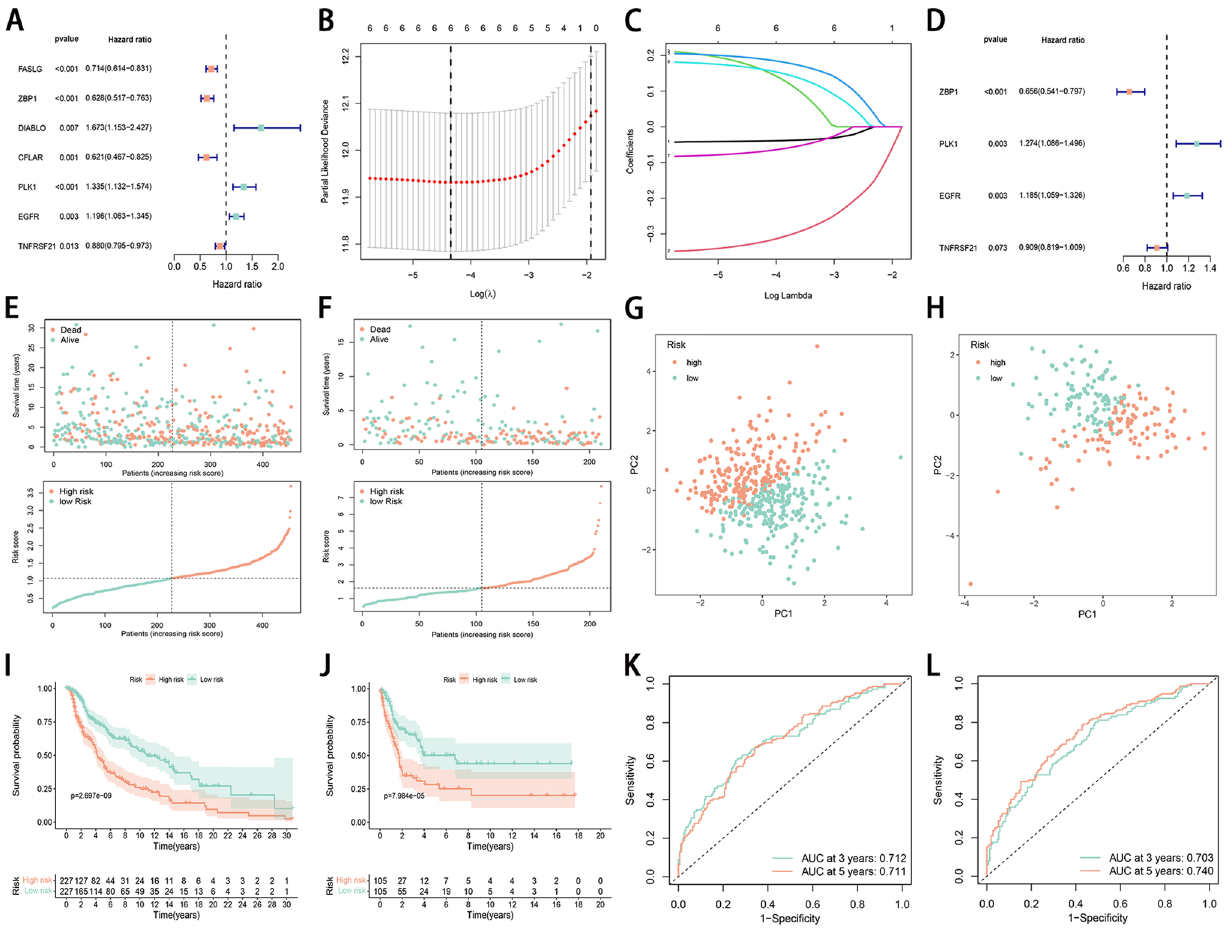
Figure 3. Necroptosis-related signature constructed and validated in the TCGA and GEO cohorts, repsectively. ( A ) The 7 necroptosis-related genes with P < 0.05 and their hazard ratios from univariate Cox proportional hazards regression analysis. ( B ) Tuning parameter selection in the LASSO model for OS-relevant genes in the TCGA cohort. ( C ) The LASSO coefficient profile of the 6 necroptosis-related genes in the TCGA cohort. The vertical line indicates the coefficient selected by LASSO. ( D ) Forrest plot showed that a total of 4 necroptosis- related genes were identified as prognosis-related by multivariate cox analysis. ( E and F ) The distribution and value of the risk scores in the TCGA and validation cohorts. ( G and H ) PCA of melanoma patients according to the risk score in the TCGA and validation cohorts. ( I and J ) Kaplan–Meier curves show that the low-risk group has significantly longer overall survival compared to the high-risk group in both the TCGA and validation cohorts. ( K and L ) ROC curve analysis shows the predictive efficiency of the established risk score in TCGA and validation